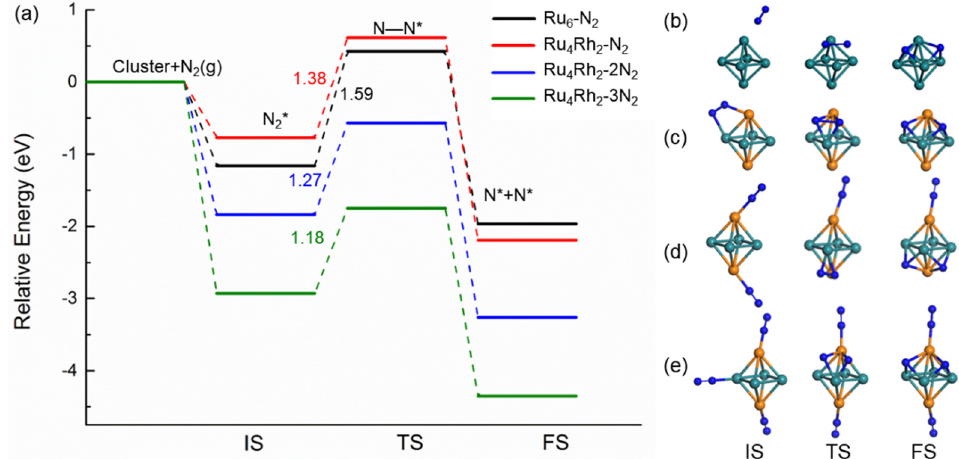
Figure 7. ( a ) Potential energy surface from density functional calculations comparing N 2 dissociation on Ru 6 and Ru 4 Rh 2 clusters, where * denotes adsorption. Geometric structure of the initial state (IS), transition state (TS), and final state (FS) of a N 2 molecule in elementary reactions on ( b ) Ru 6 and ( c ) Ru 4 Rh 2 clusters, including ( d ) two and ( e ) three N 2 molecules in elementary reactions on Ru 4 Rh 2 cluster. The plot shows that alloying Ru 4 Rh 2 cluster relative to Ru 6 cluster leads to enhancement in activity, and N 2 coadsorption on Ru 4 Rh 2 cluster is beneficial to N 2 dissociation.